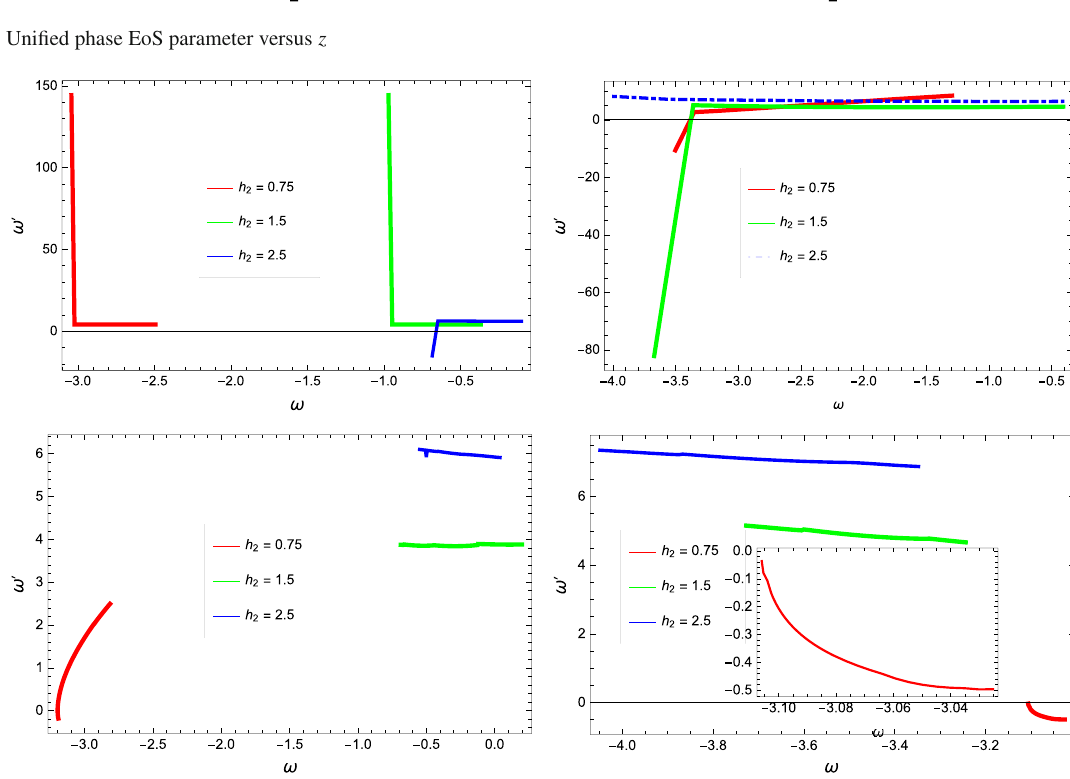
Fig. 11 Evolution of ω – ω (cid:2) versus